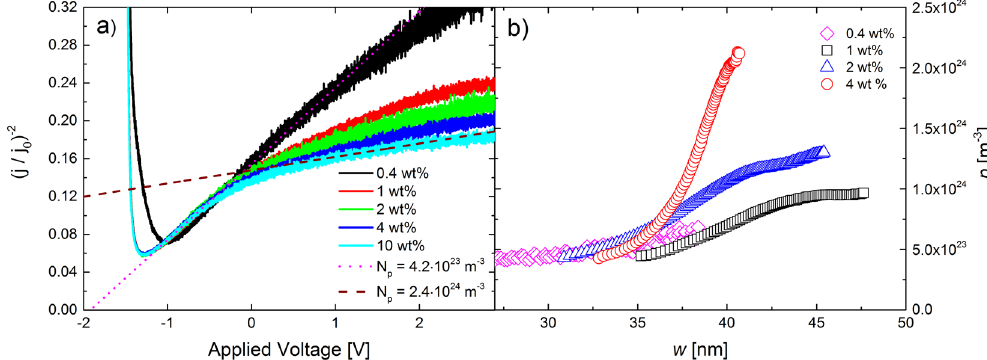
Figure 5. ( a ) Capacitive extraction current transients of BF-DPB:C 60 F 36 devices with two layers of different dopant concentrations; in the lower doped layer ( d = 40 nm) the C 60 F 36 to BF-DPB weight ratio is 0.2% (corresponding to molar ratio of 0.001) in the more heavily doped layer ( d = 70 nm) the dopant concentration is varied from 0.4 wt% to 10 wt% (corresponding to molar ratios of 0.002 and 0.057). In ( b ) the charge-carrier profiles (as determined by Eq. (11)) of four devices with different dopant concentration in the highly doped layer are shown.